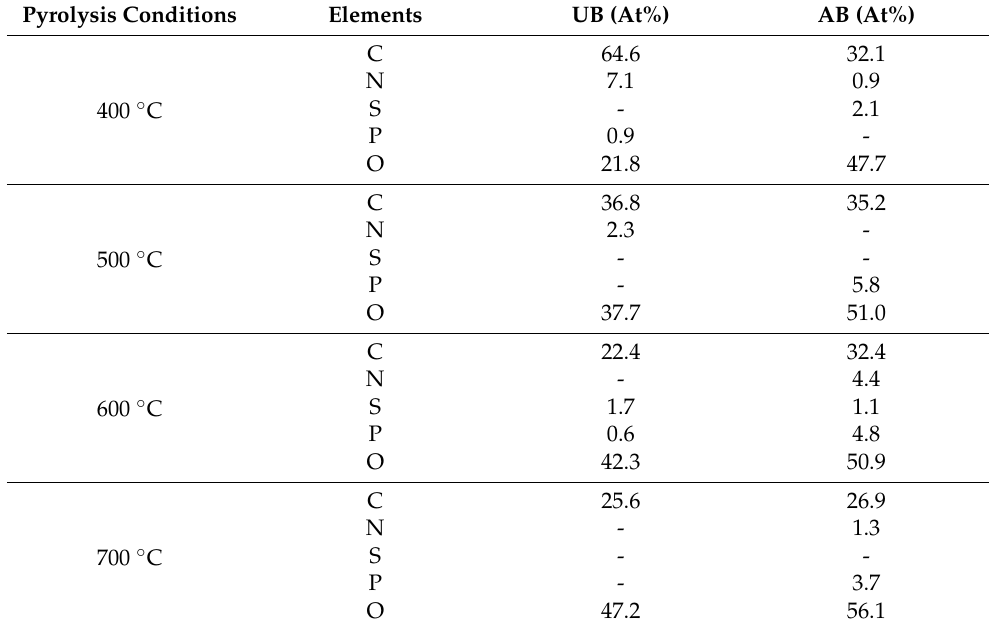
Table 5. Surface compositions of unactivated biochar (UB) and activated biochar (AB) obtained by X-ray Photoelectron